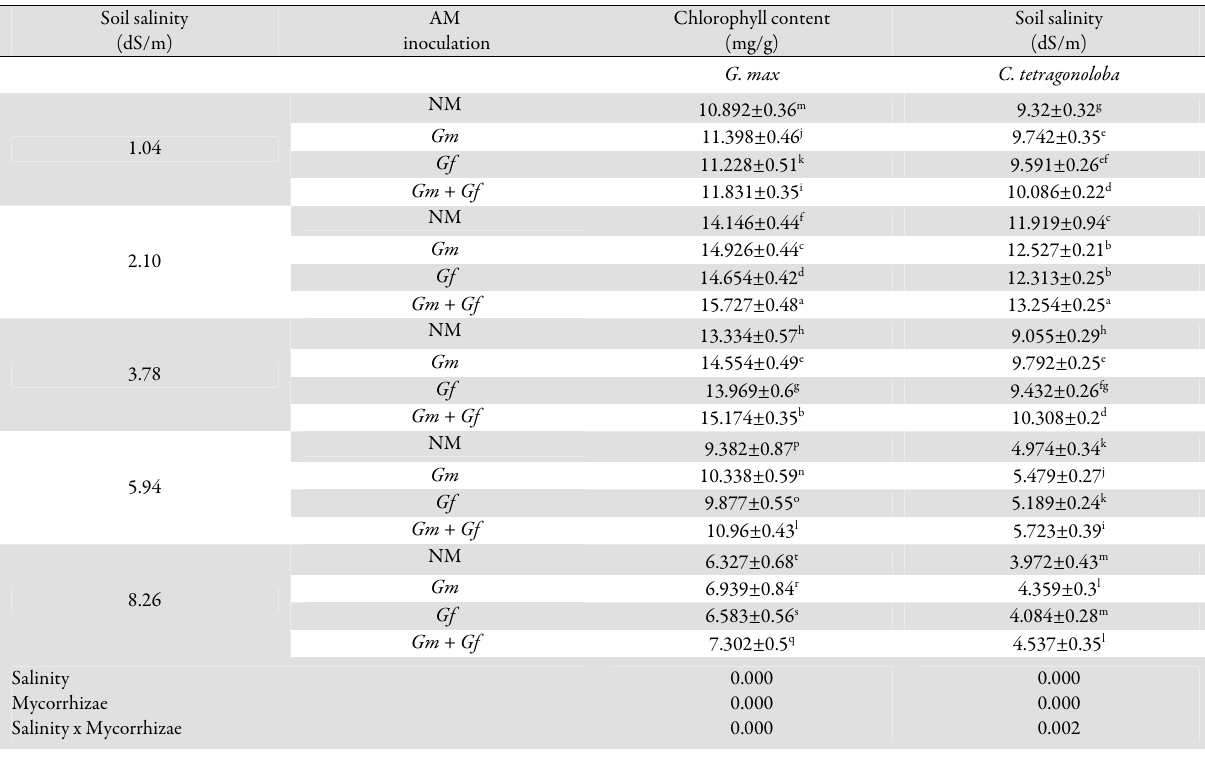
NM: non mycorrhizal, Gm: Glomus mosseae , Gf: Glomus fasciculatum , Gm+Gf: Glomus mosseae + Glomus fasciculatum , values are mean±SE of three replicates. Within column, different letters for each treatment indicate statistically significant difference ( P <0.05) by Duncan’s test after performing